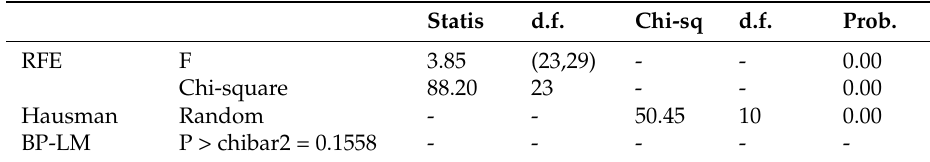
Table 7. Model test results: redundant fixed effects (RFE) test; Breusch-Pagan and Lagrangian multiplier (BP-LM)